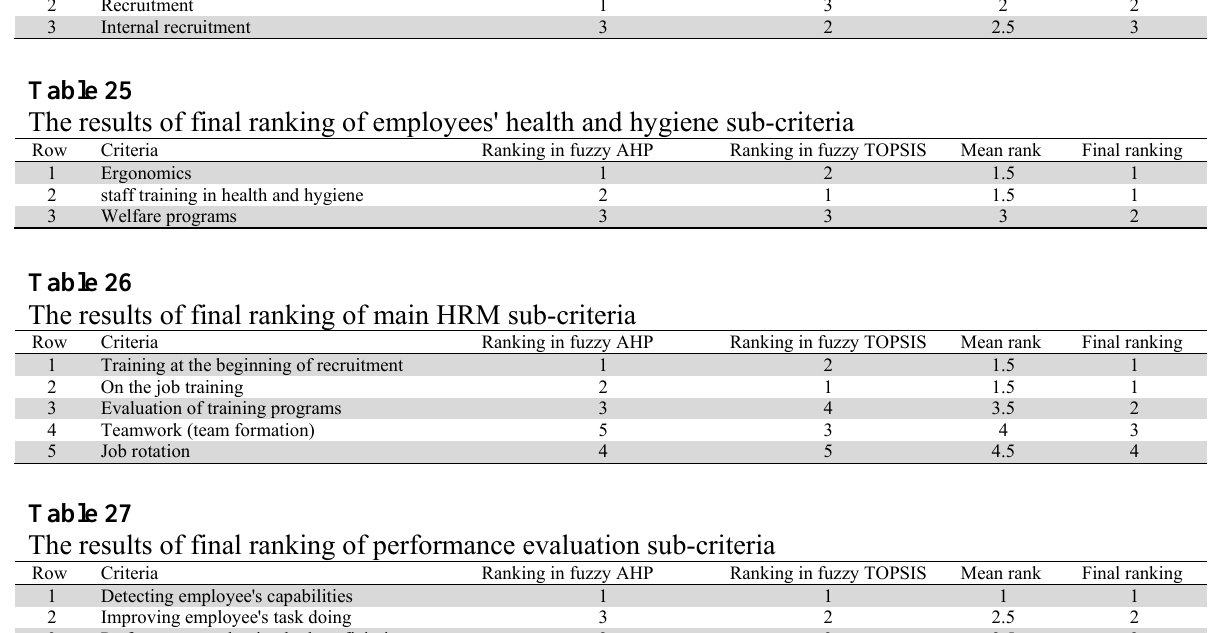
The results of final ranking of recruitment and selection sub-criteria Row Criteria Ranking in fuzzy AHP Ranking in fuzzy TOPSIS Mean rank Employment and selection Recruitment Internal recruitment